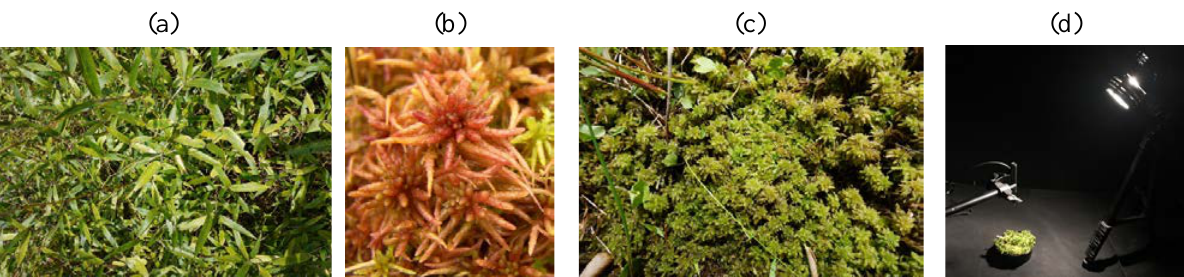
Figure 5. Samples of plant species and the laboratory darkroom. (a) P. heteroclada in Plot 1; (b) red and green S. magellanicum in Plot 1; (c) green S. magellanicum in Plot 2; (d) the indoor spectroscopy (ASD FieldSpec3) setup used for the water content gradient experiment. (a) and (c) from Pang et al .